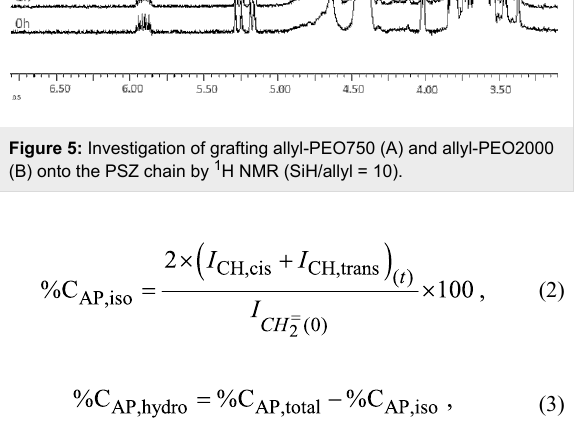
the region of low fields ( C H 3 − at 9.2ppm, − C H= at 145.6ppm